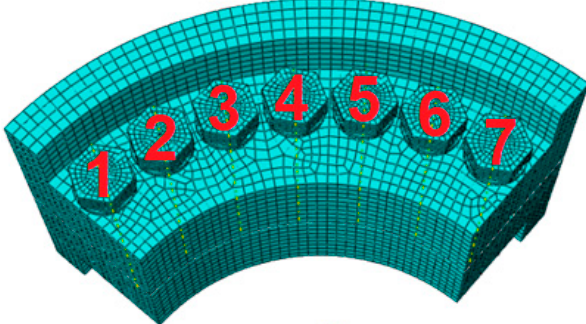
Figure 6. Bolt numbers according to FE model .